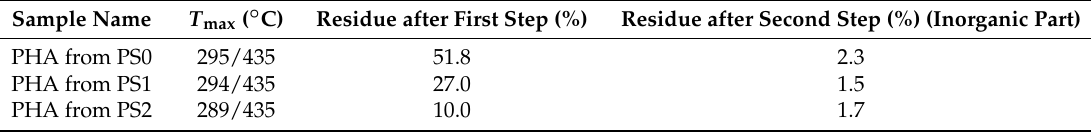
Table 5. The thermogravimetric parameters for the PHA samples produced after 48 h fermentation with PS0–2 as an additional carbon source in TSB media.